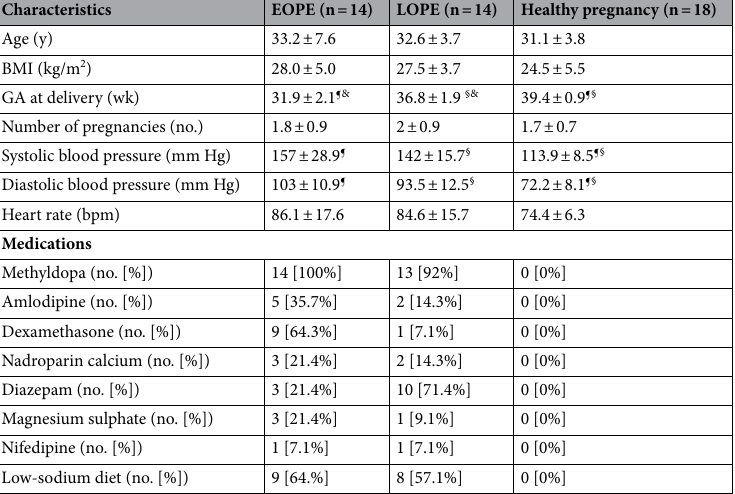
(Fig. 1b). Both PCA and heatmap revealed that the proteomes are heterogeneous across all the samples. Following PCA, the differential expression (DE) analysis was performed by three separate comparisons; (i) EOPE versus healthy pregnancy, (ii) LOPE versus healthy pregnancy and (iii) EOPE versus LOPE, while adjusting for GA at delivery. DE proteins were defined as FDR < 0.05. In total, there were 26 and 20 differentially abundant proteins in EOPE versus healthy pregnancy and LOPE versus healthy pregnancy, respectively, and one protein was dif- ferentially abundant between EOPE and LOPE (Table 3; Figs. 1c–e and 2a; Supplementary data 2). Overall, the differences in proteome profiles between EOPE or LOPE and healthy pregnancy were largely associated with impaired angiogenesis and included perturbed abundance of inter-alpha-trypsin inhibitor heavy chain H2-4 (ITIH3 in EOPE and ITIH2/4 in LOPE) 8 , insulin-like growth factor-binding protein 4 (IGFBP4) 9–12 and histidine-rich glycoprotein (HRG) 13–15 (Fig. 2a). Immunoglobulin heavy variable 1/OR15-1 (IGHV1OR15-1) was the only protein differentially abundant between the two subtypes of preeclampsia, being substantially higher in abundance in EOPE compared to LOPE (FC = 14.29, FDR = 0.005) (Fig. 2b). Through our targeted proteom- ics we validated the changes observed with ITIH3 in EOPE (logFC = 0.429, p = 0.02) and ITIH 2&4 in LOPE (logFC = 0.290, p = 0.005 and logFC = 0.3498, p = 0.005, respectively). ITIH4 was also significantly upregulated in EOPE (logFC = 0.294, p = 0.02) therefore making ITIH2 uniquely perturbed in LOPE (Table 3). Interest- ingly, between EOPE and LOPE, IGHV1OR15-1 was not significantly different in abundance using the targeted proteomics but rather APOC3 (logFC = − 0.939, p < 0.0001) and HRG (logFC = 0.671, p < 0.0001). HRG is a well-studied biomarker of preeclampsia related to platelet haemostasis 16–18 that was increased ~ twofold in both phenotypes of preeclampsia (EOPE: FDR = 0.008; LOPE: FDR = 0.004) when we applied untargeted proteomics. However, following validation, HRG showed similar trend in EOPE ( p = 0.007) versus healthy controls whereas it was downregulated in LOPE ( p = 0.005) versus healthy controls and as such it was differentially abundant between the two phenotypes. Furthermore, there were 11 DE proteins commonly shared between EOPE and LOPE. Immunoglobu- lin lambda variable 3–21 (IGLV3-21) was the top differentially abundant protein shared between EOPE (FDR = 0.002) and LOPE (FDR = 0.004), with an approximately 50% decrease in its abundance in either of phe- notypes compared to healthy pregnancy controls. This was also confirmed as part of validation using targeted proteomics. Well-characterised preeclampsia biomarkers including fibronectin 1 (FN1) 19,20 and complement factor D (CFD) 21,22 were ~ twofold increased in abundance and among the most significant abundant proteins in both EOPE and LOPE, compared to control. Whilst CFD did not undergo validation, using targeted proteomics FN1 was only significant in EOPE ( p = 0.007) and not in LOPE, versus healthy controls. The proteins displaying significant changes of abundance were highlighted in a three-dimensional plot (Fig. 2b; Supplementary data 3). Among the proteins with significant fold changes in EOPE compared to healthy controls, a series of proteins have previously been reported as biomarkers of preeclampsia, including serpin fam- ily A member 5 (SERPINA5) 23 , pappalysin 2 (PAPPA2) 24,25 , hepatocyte growth factor activator (HGFAC) 26,27 and thymosin beta-4 (TMSB4X) 28 . Whilst SERPINA5, PAPPA2, and TMSB4X did not undergo validation using targeted proteomics, HGFAC was not statistically significant as part of the validation (Table 3). IGFBP4, a protein significantly increased in abundance in EOPE (log 2 FC = 4.25, FDR = 0.0003) and LOPE (log 2 FC = 4.91, FDR = 0.004), compared to controls, is known to have anti-angiogenic properties 9–12 , adding further evidence to the central role of impaired angiogenesis in preeclampsia.